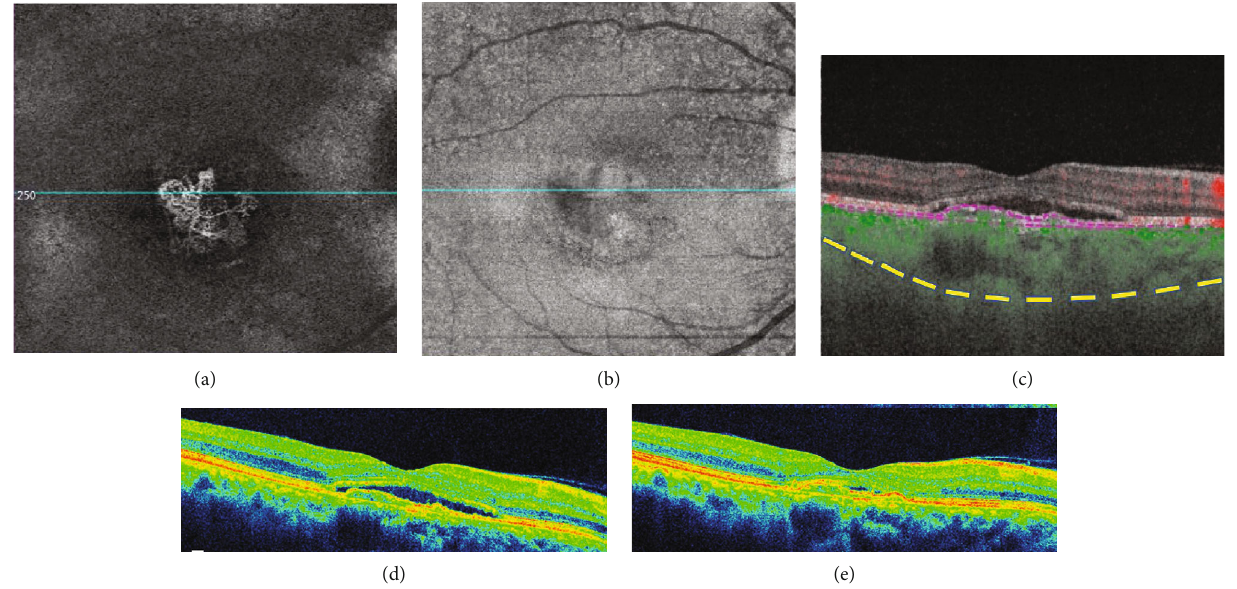
Figure 14: Chronic central serous chorioretinopathy of the right eye with secondary choroidal neovascularization (CNV). A 53-year old female with chronic central serous chorioretinopathy presented with worsening subretinal fl uid. Using swept source optical coherence tomography angiography (SS-OCTA – PLEX Elite 9000, Carl Zeiss Meditec, Dublin, CA) 6 × 6 scans were performed; shown is the slab between the retinal pigment epithelium (RPE) and Bruch ’ s membrane. (a) En face angiography showed the presence of type 1 choroidal neovascularization (CNV). (b) En face structural imaging showed the RPE elevation due to underlying CNV. (c) B-scan demonstrated subretinal fl uid. The presence of a pigment epithelial detachment was seen, with increased fl ow (green) within the detachment indicating increased choroidal fl ow in the presence of CNV. The sclerochoroidal junction (yellow dashes) was highlighted to demonstrate the thick choroid. OCT prior to (d) and after (e) anti-vascular endothelial growth factor injections showed improvement of subretinal fl uid.